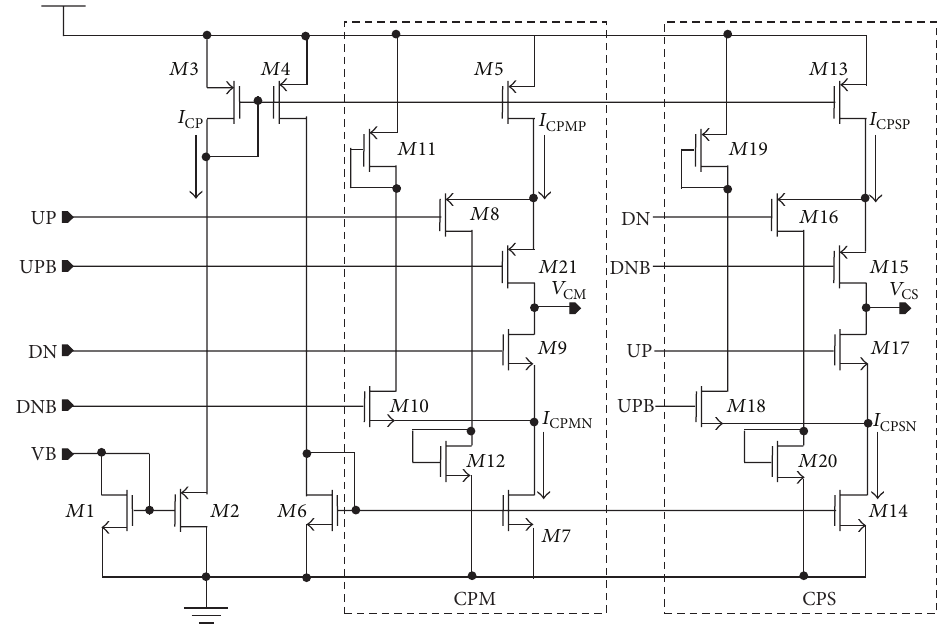
Figure 10: Circuit diagram of CP. The CP consists of the CPM and the CPS.